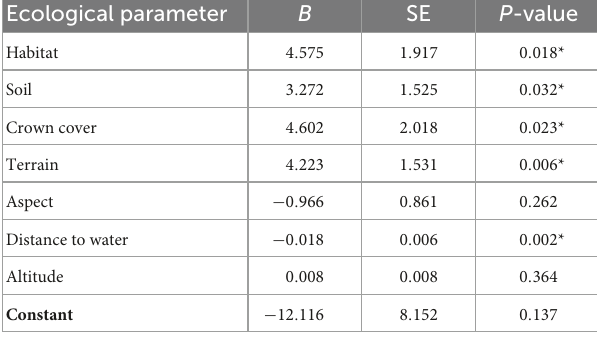
TABLE 2 Estimates and statistics for the model predicting the relationship between habitat variables and the presence of burrows, according to the likelihood ratio testing of the parameters of the logistic regression model.